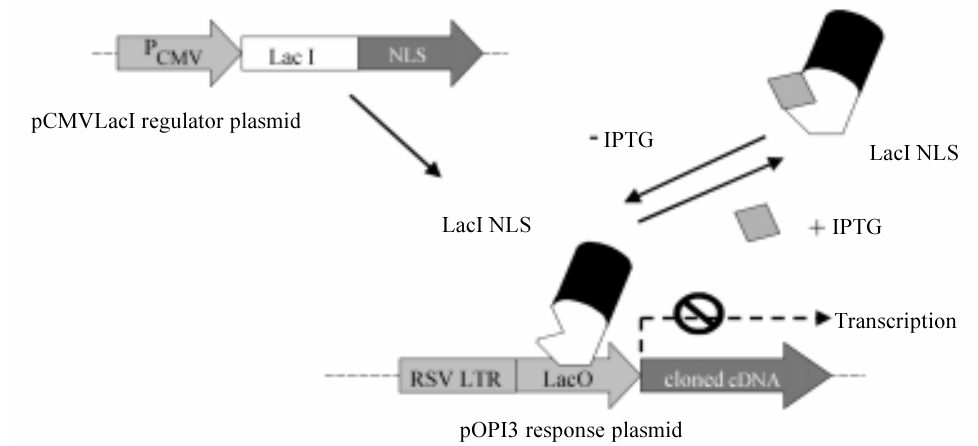
Figure 1 - Schematic presenta- tion of the LacSwitch (Strat- agene) expression system. The repressor protein derived from LacI is fused with the SV40 nuclear localization sequence (NLS) and is constitutively pro- duced from the cytomegalovirus promoter (P CMV ) present in the regulator plasmid. In the ab- sence of isopropyl thio ß-d- galactopyranoside (IPTG), the re- pressor localized in the nucleus binds to the operator sequences present between the Rous sar- coma virus (RSV) promoter and the cloned cDNA in the re- sponse plasmid, blocking tran- scription. When IPTG is added to the cells it binds to the re- pressor, which, in turn, releases the operator sites and allows free transcription of the cDNA. LTR, 5’ long terminal